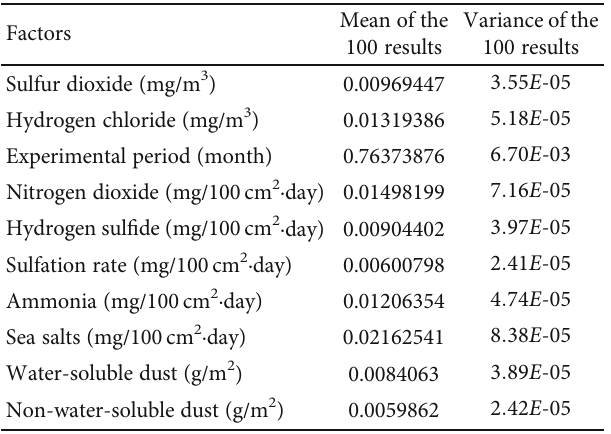
Table 5: Mean and variance of the importance of the pollutant factors after 100 repetitions of the